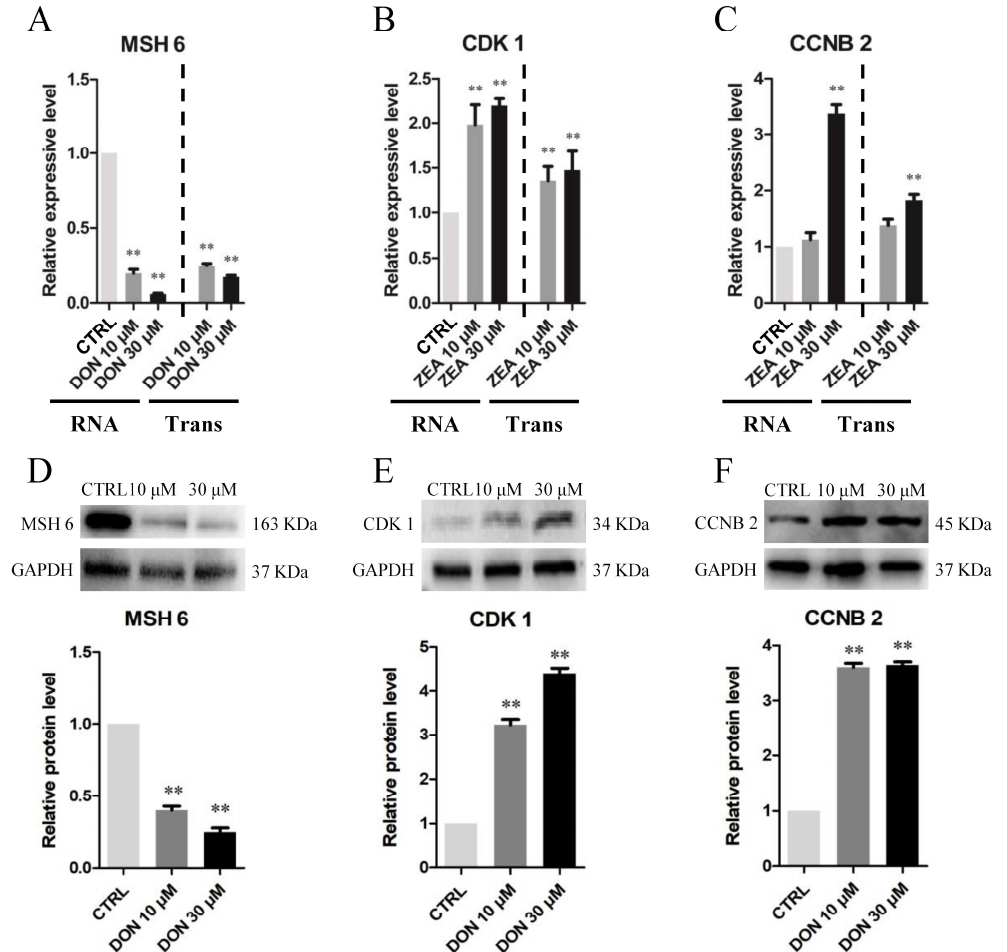
Figure 14. DON and ZEA exposure affected the mRNA and protein abundance levels of tumorigenesis-related genes in cultured GCs. ( A – C ) Quantitative RT-PCR for MSH6 in the DON treatment group, CDK1 and CCNB2 in the ZEA exposure groups. The mRNA levels of all genes were normalised to the GAPDH gene in SCs. ( D – F ) The protein levels of MSH6 / GAPDH in the DON treatment group, CDK1 / GAPDH and CCNB2 / GAPDH in the ZEA treatment group were detected by Western blot. The protein levels were normalised to GAPDH . The results are presented as the means ± SD. All experiments were repeated at least three times. ** p < 0.01.